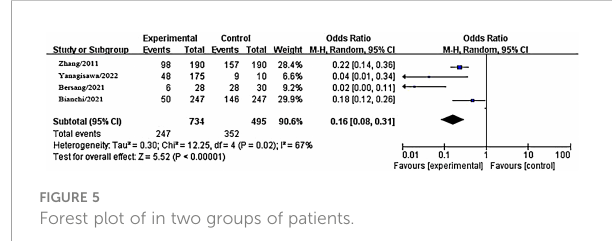
FIGURE 5 Forest plot of in two groups of